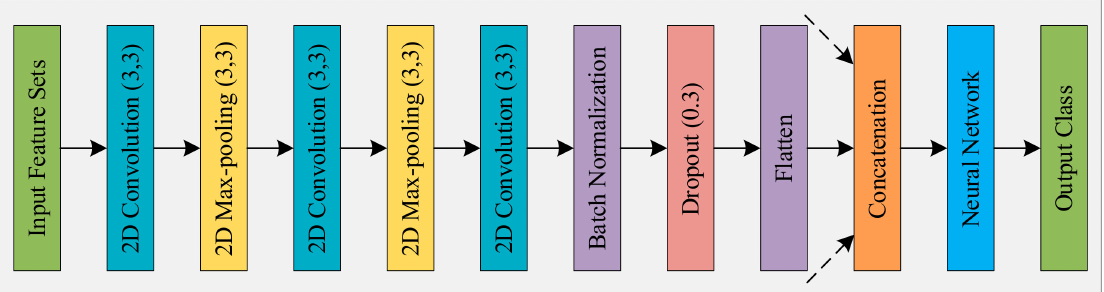
Figure 7. The architecture of the employed CNN model (single